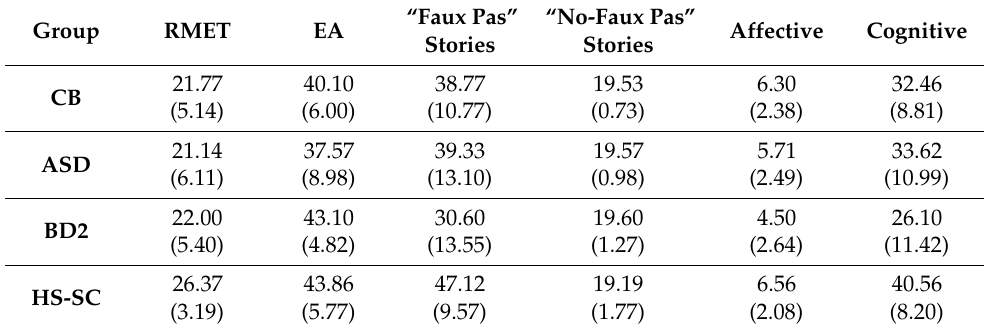
Table 2. Means and standard deviation of scores obtained in each SC test by each group.